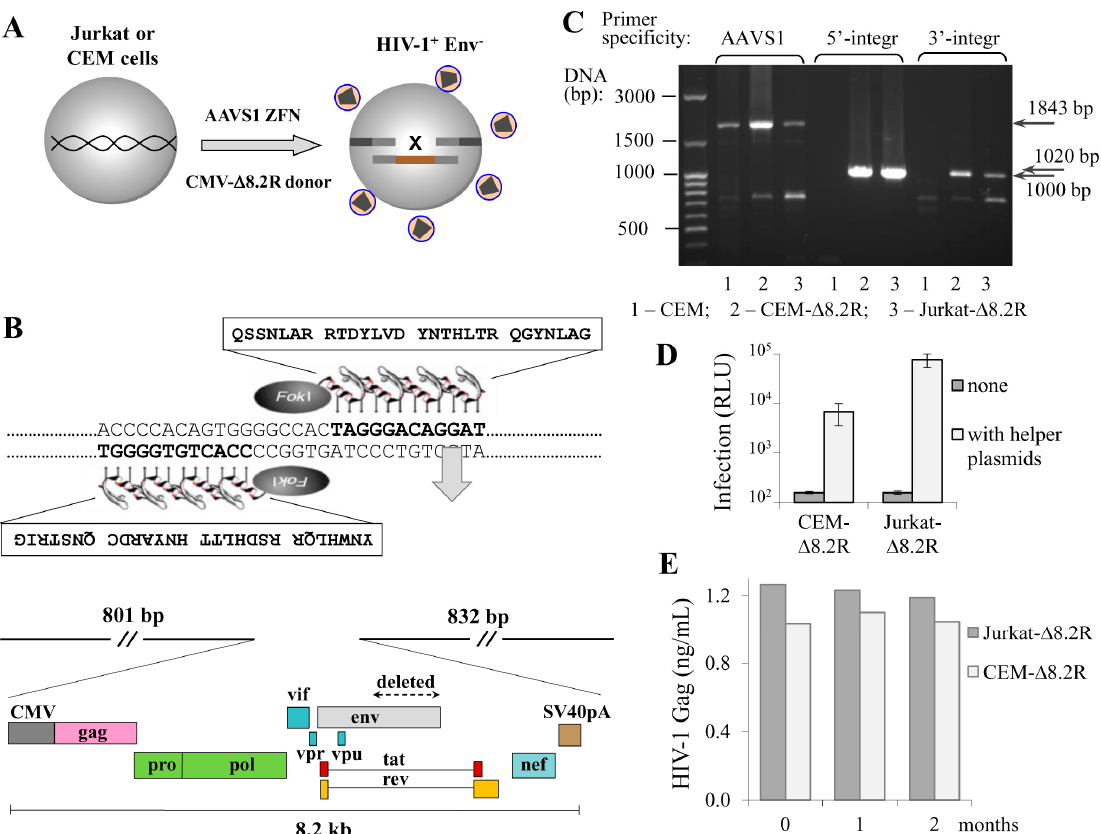
Figure 1. Engineering human T cell lines with the human immunodeficiency virus type 1 (HIV-1) packaging genome integrated into adeno-associated virus integration site 1 (AAVS1) locus. ( A ) a schematic drawing showing that cotransfection of CEM or Jurkat T cells with the AAVS1-specific zinc finger nuclease (ZFN) expression plasmid and HIV-1 donor DNA ∆ 8.2R resulted in generation of cells producing nascent virus-like particles; ( B ) the amino acid sequences of AAVS1-specific zinc finger proteins that recognized the DNA target sequences (on the top) and a schematic map of pAAVS1- ∆ 8.2R donor vector (on the bottom) used to generate HIV-1 transgenic T cells; ( C ) confirmation of ∆ 8.2R transgene integration at the AAVS1 locus. Genomic DNAs from CEM cells (negative control), CEM- ∆ 8.2R, and Jurkat- ∆ 8.2R clones (cells containing the transgene) were isolated and used to set up PCR with integration-specific primers; ( D ) transgenic T cells could mediate HIV-1 infection. Cells were transfected with a mock plasmid (grey bars) or pUCHR-inLuc-mR and pIII-NL4 Env plasmid DNAs (open bars) and mixed with Raji/CD4 target cells. Luciferase activity was measured 3 d posttransfection. The averages of three independent experiments with the standard deviations are presented; ( E ) stability of nascent virion production by transgenic cells. Supernatants from freshly generated CEM- ∆ 8.2R and Jurkat- ∆ 8.2R cells (zero time point) or after 1 or 2 months of passage were harvested and quantified for viral Gag production using p24 ELISA Kit.